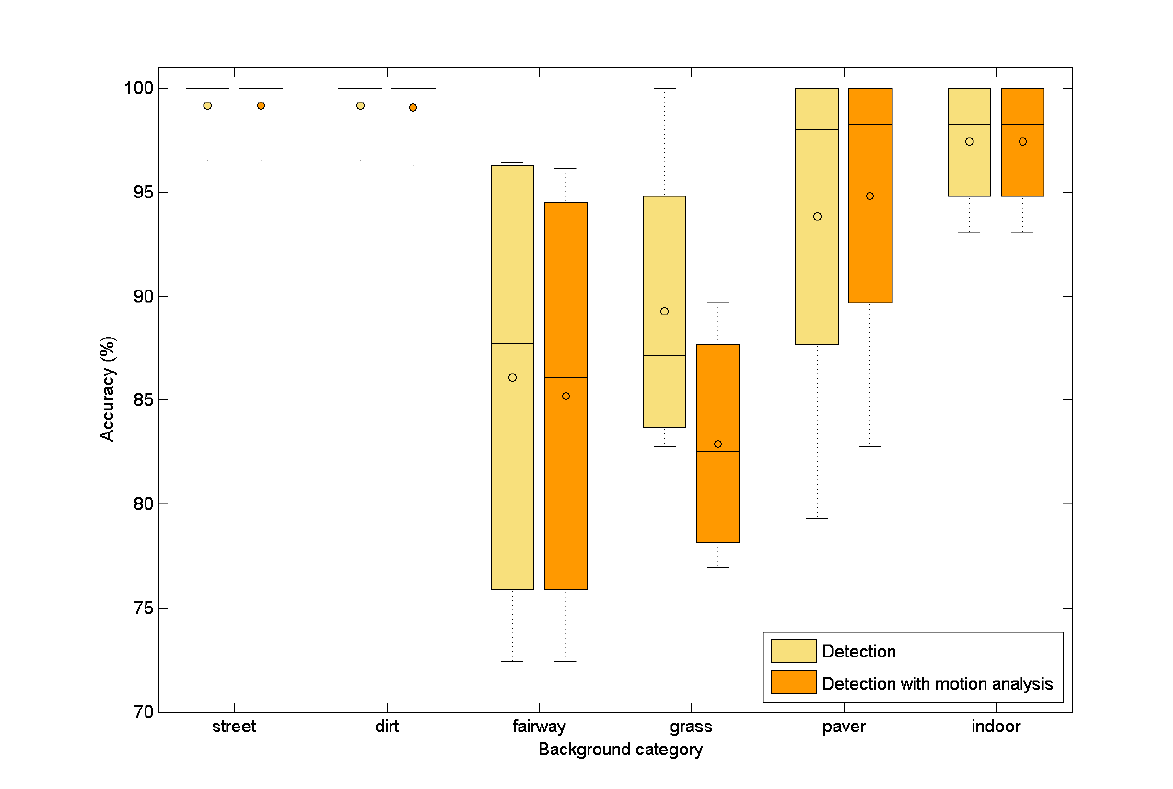
Figure 8. Laser spot detection accuracy for the mCHT-based detector (yellow boxplots) and for the mCHT-based detector and motion pattern analysis (orange boxplots) for different backgrounds.